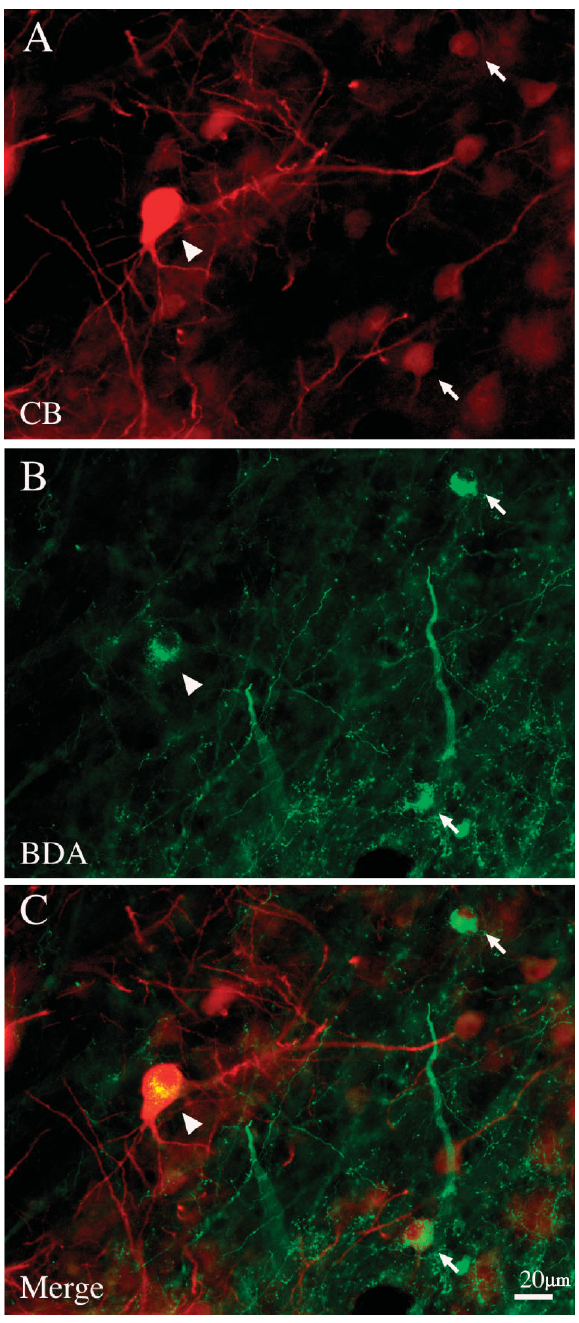
Figure 4. Giant pulvinocortical relay neurons retrogradely labeled by BDA are CB+ . ( A ) Giant neuron (arrowhead) intensely immunofluorescent for CB. Two other, smaller CB + neurons are indicated by arrows. ( B ) Same sec- tion, reacted with streptavidin-Alexa488 to visualize BDA transported from an injection in posterior area TE. Arrowhead and arrows indicate the same three neurons as in A. ( C ) Merged image directly demonstrates that these three CB + neurons are also labeled by